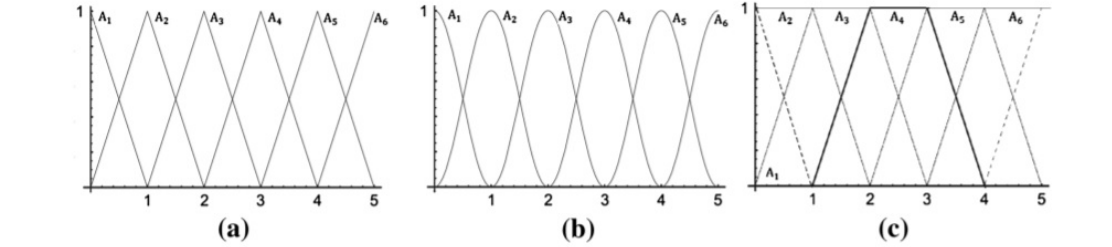
Figure 1. Examples of basic functions. ( a ) Triangular function, ( b ) sinusoidal function, ( c ) trapezoidal